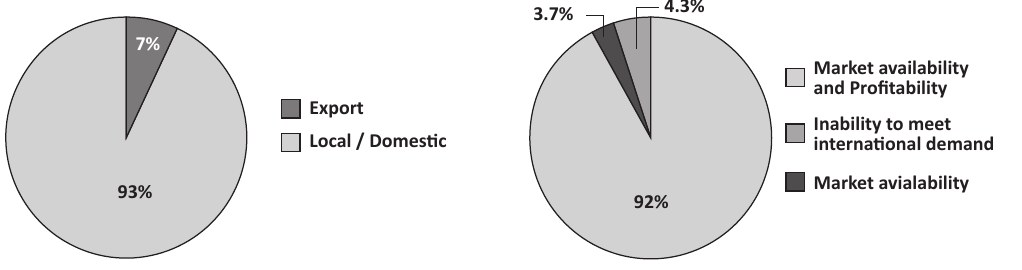
FigUre 2. Reasons for manufacturers’ choice of market for furniture